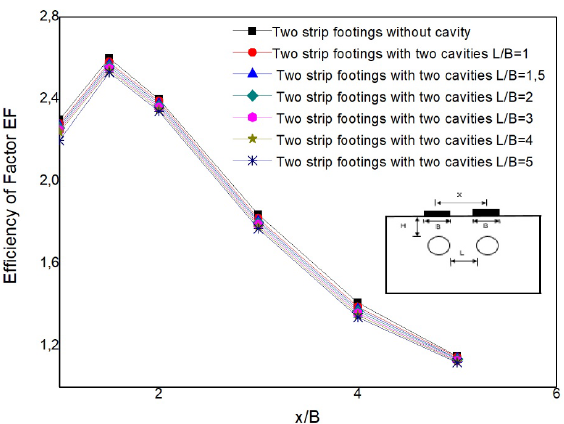
Figure 10: Variation of EF as a function of x/B in the following cases: two strip footings without cavities and with cavity (H/B = 3); (L/B = 1.0, L/B = 1.5, L/B = 2.0, L/B = 3.0, L/B = 4.0, and L/B = 5.0)